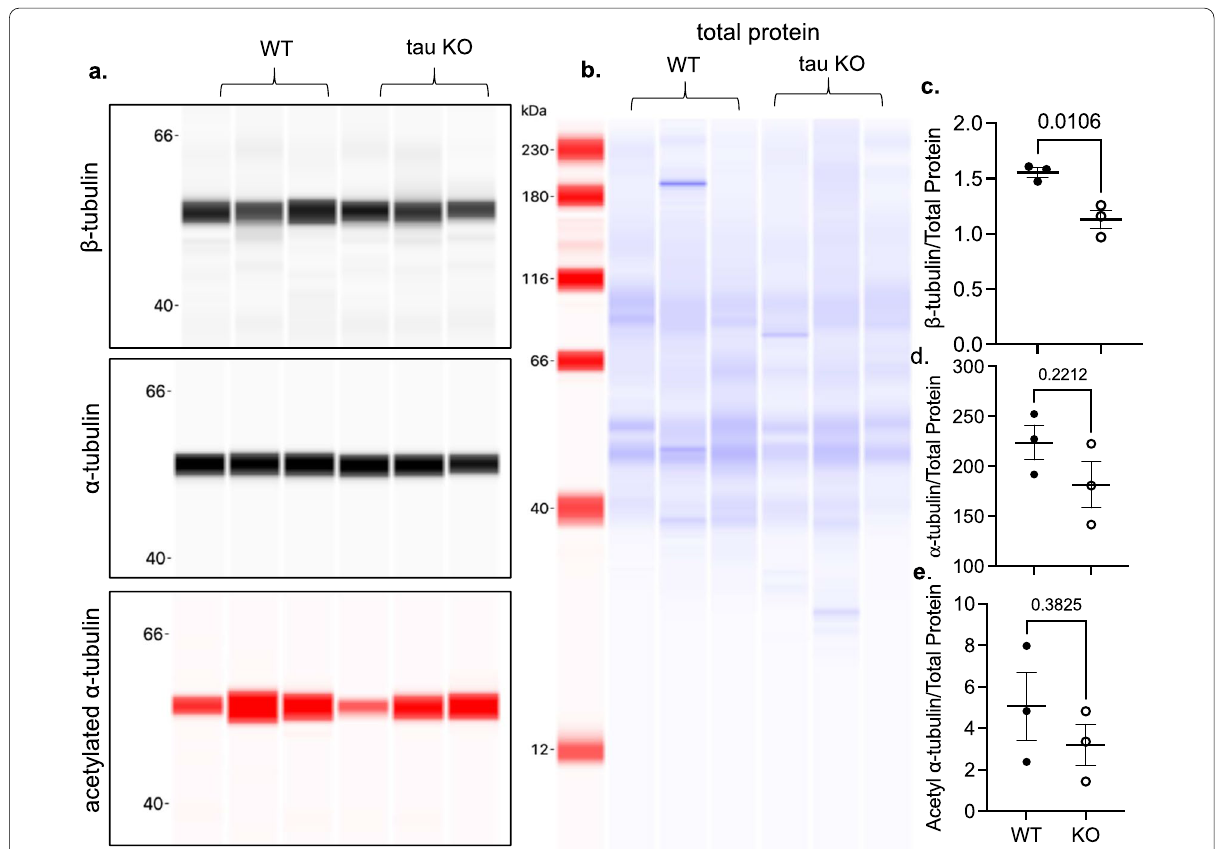
Fig. 5 Artificial immunoblots generated from capillary electrophoresis (Jess ™ ) using 1.2 μg protein lysate from total tubulin extracts. a Lysates were immunoprobed for α-tubulin, β-tubulin and acetylated α-tubulin and normalized to b total protein., c – e Normalized protein levels were plotted and statistically analyzed ( n 3/group); p values from unpaired t tests are indicated on the =